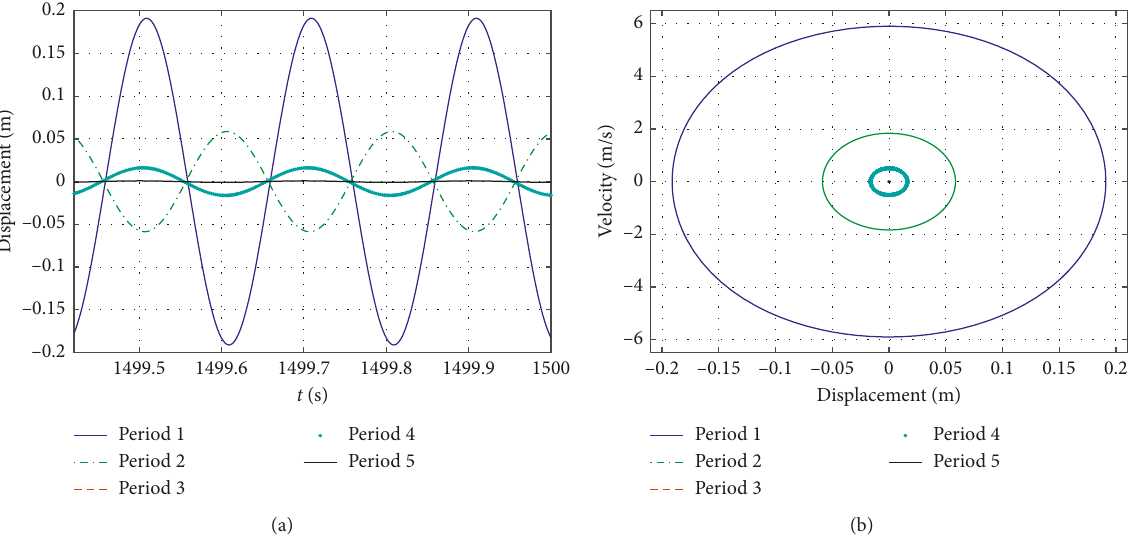
Figure 12: Five periodic oscillators’ (a) displacement time history curves and (b) phase diagrams (effective positive mass).